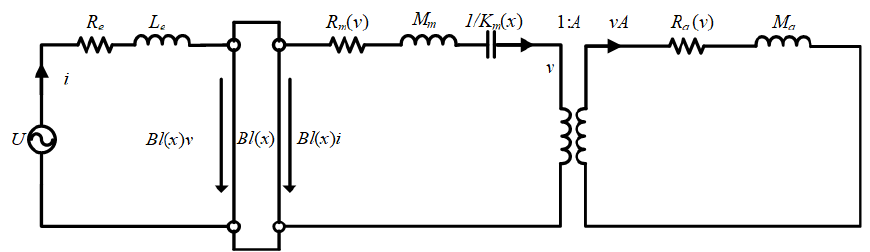
Figure 3. ECM model of miniature loudspeakers considering nonlinear acoustic damping.